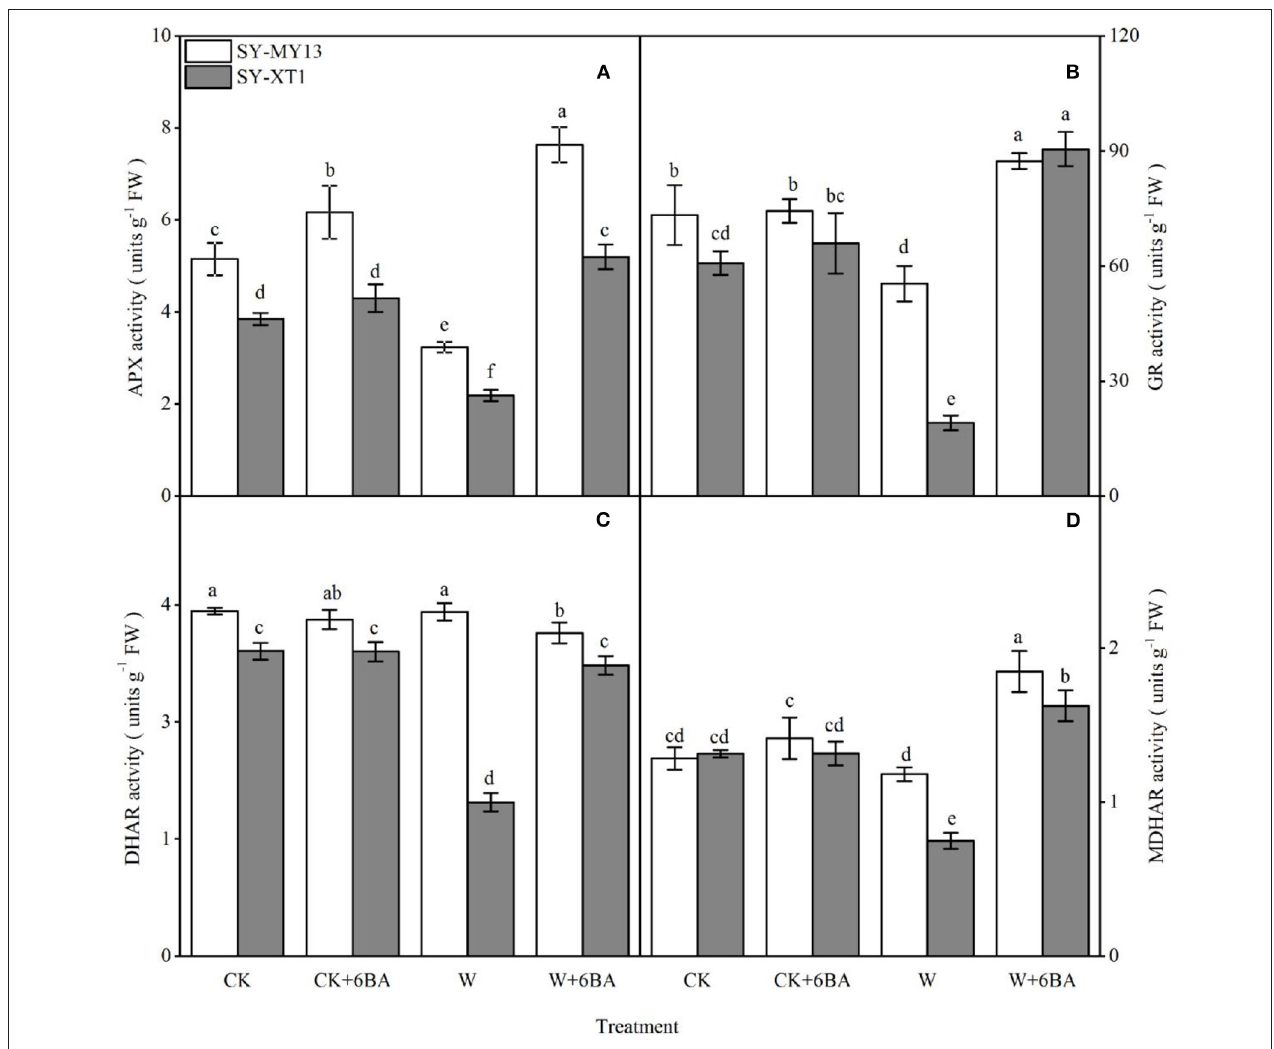
FIGURE 4 | Effects of 6-BA on ascorbate peroxidase (APX) (A) , glutathione reductase (GR) (B) , dehydroascorbate reductase (DHAR) (C) , and monodehydroascorbate reductase (MDHAR) (D) activity in two waxy corn inbred lines experiencing waterlogging. CK, normal watering conditions only; CK + 6-BA, 0.5mM of 6-BA plus normal watering conditions; W, waterlogged; W + 6-BA, addition of 0.5mM of 6-BA plus waterlogging stress conditions. Data represent means ± SD of three replicates. For each variable, means with different lowercase letters were significantly different ( P <